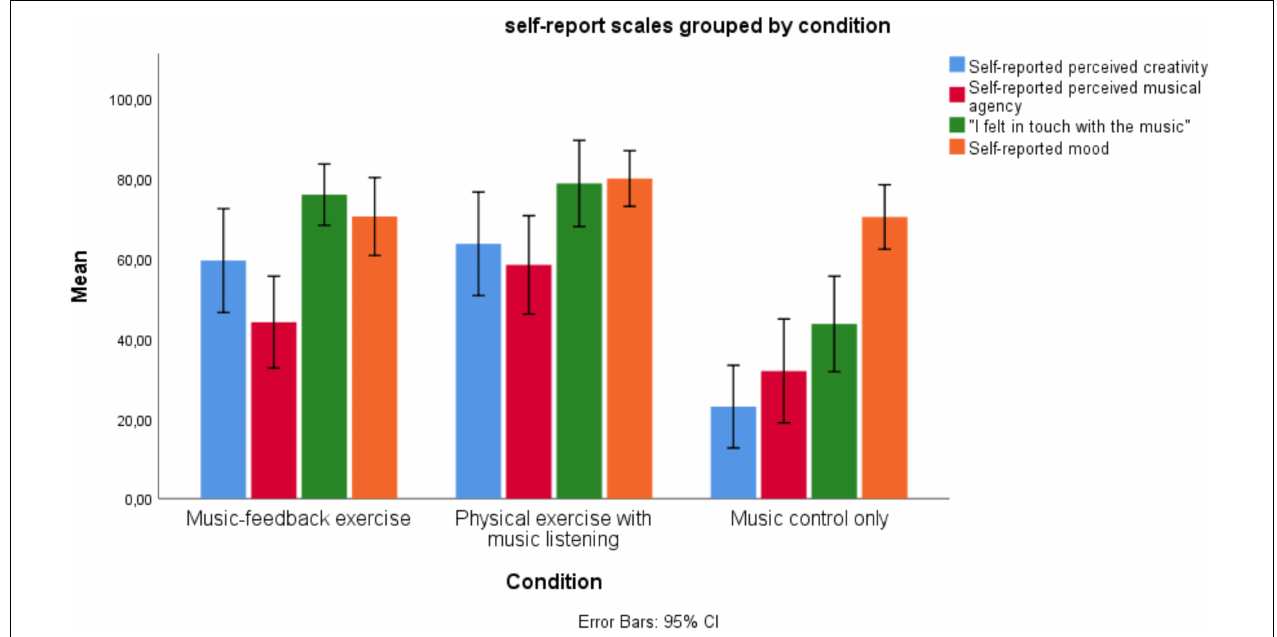
FIGURE 2 | Mean results of self-report scales collected postintervention between conditions. Error bars represent 95% confidence interval.